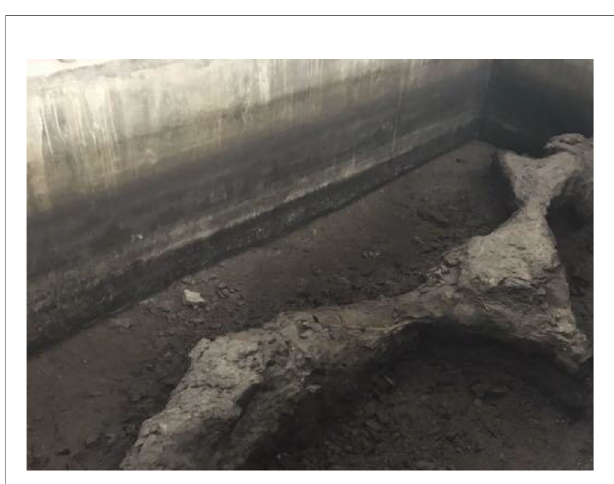
FIGURE 2 | Photo of the cut-off wall constructed in